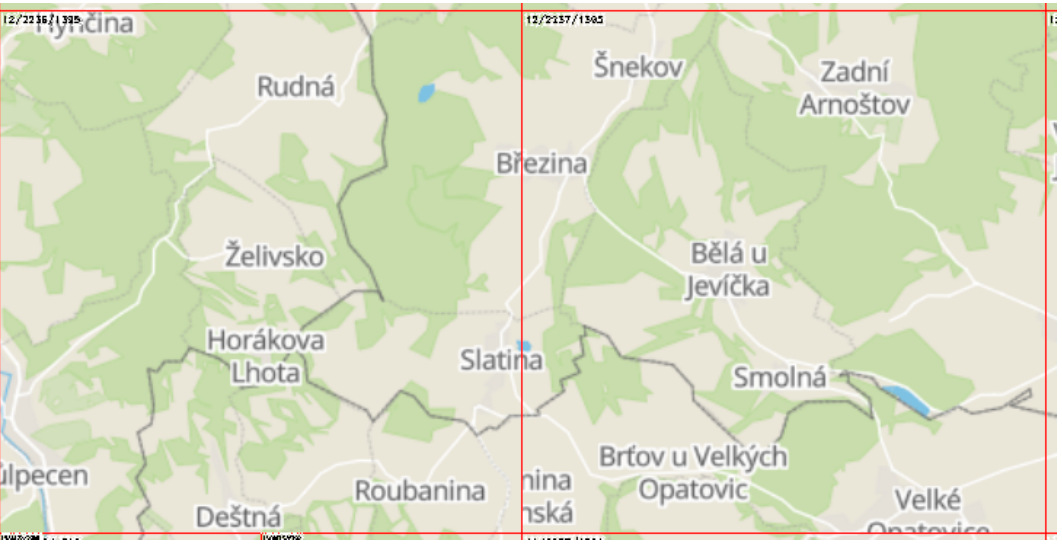
Figure 15. Incomplete labelling on the edge of the raster tile.